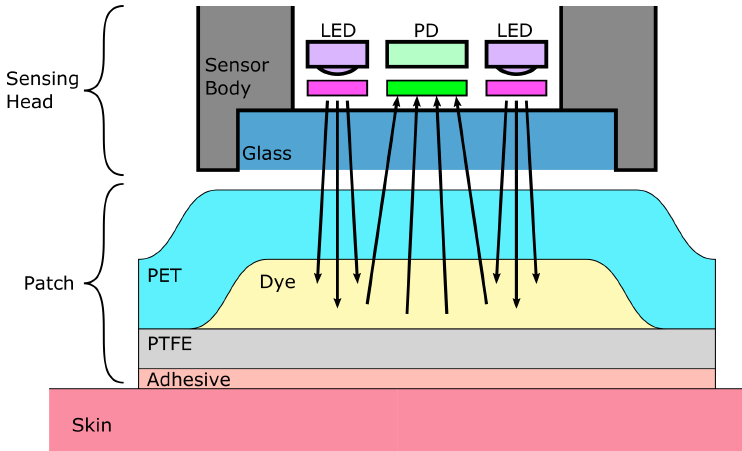
Figure 16. The dye-based fluorescent transcutaneous sensor consists of two parts. ( Top ) a sensing head with the LEDs and photodiode covered with their emission and reception filters (bright purple and green rectangles) and enclosed in a solid body, protected by a covering glass. ( Bottom ) a multilayer sensing patch stuck on the skin, consisting in—from top to bottom—a transparent layer, impermeable towards CO 2 —e.g., PET—a layer of CO 2 sensitive dye in a polymer matrix, a layer of ion-impermeable, CO 2 -permeable material such as PTFE for CO 2 diffusion from the skin into the dye, and a thin adhesive layer to maintain the patch onto the skin. See Section 2.3.4 for a detailed review of material choices as well as their advantages and drawback, when designing a dye-based CO 2